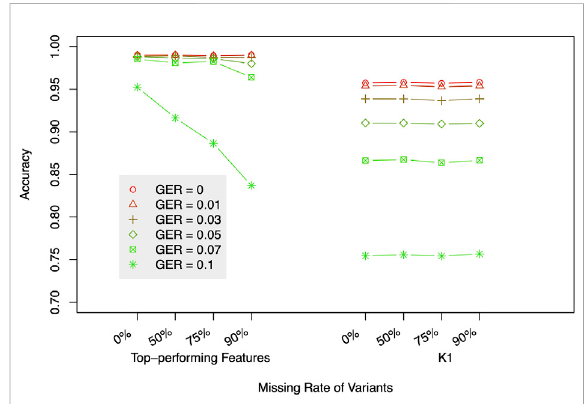
FIGURE 7 The impact of missing data on relationship degree classi fi cation. The label of the x -axis represents missing rates with two different sets of features (top-performing features vs. K1). GER = genotyping error rate of the test dataset.